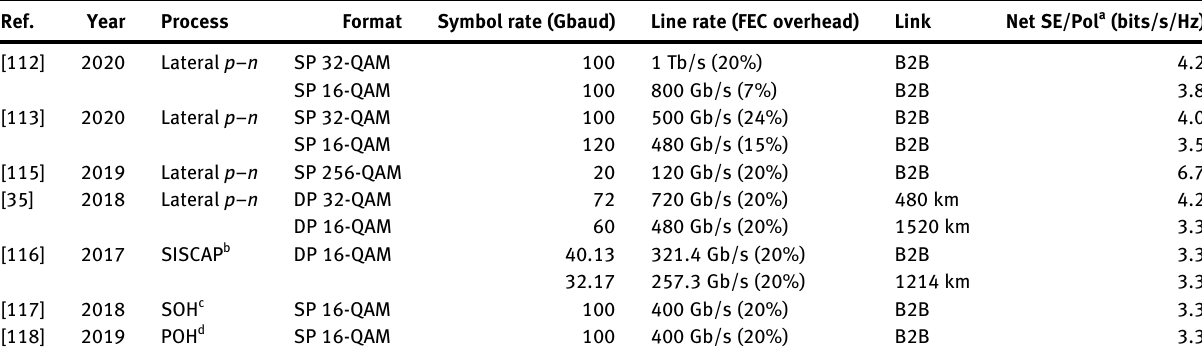
Table  : Some state-of-the-art demonstrations of high baud rate integrated silicon IQ modulators. Ref.